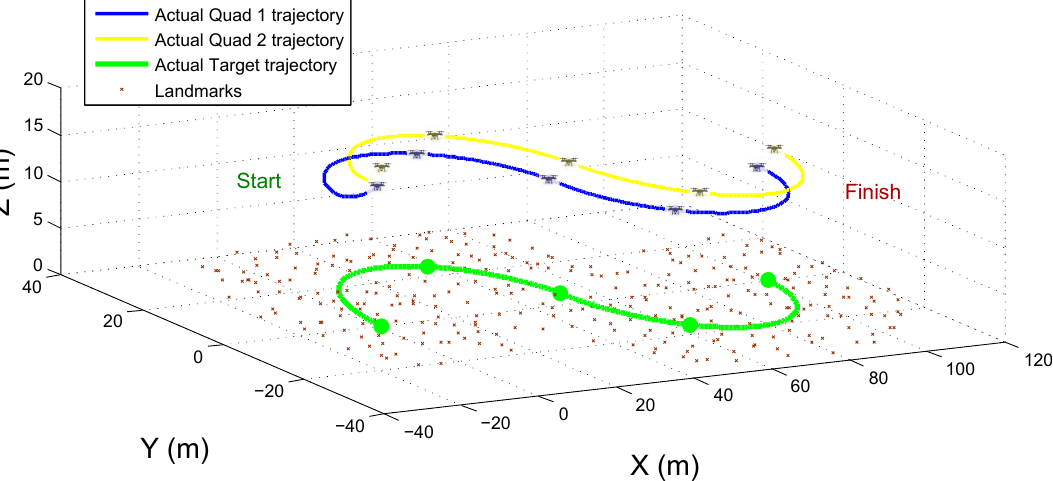
Figure 6. Actual trajectories followed by the target, Quad 1 and Quad